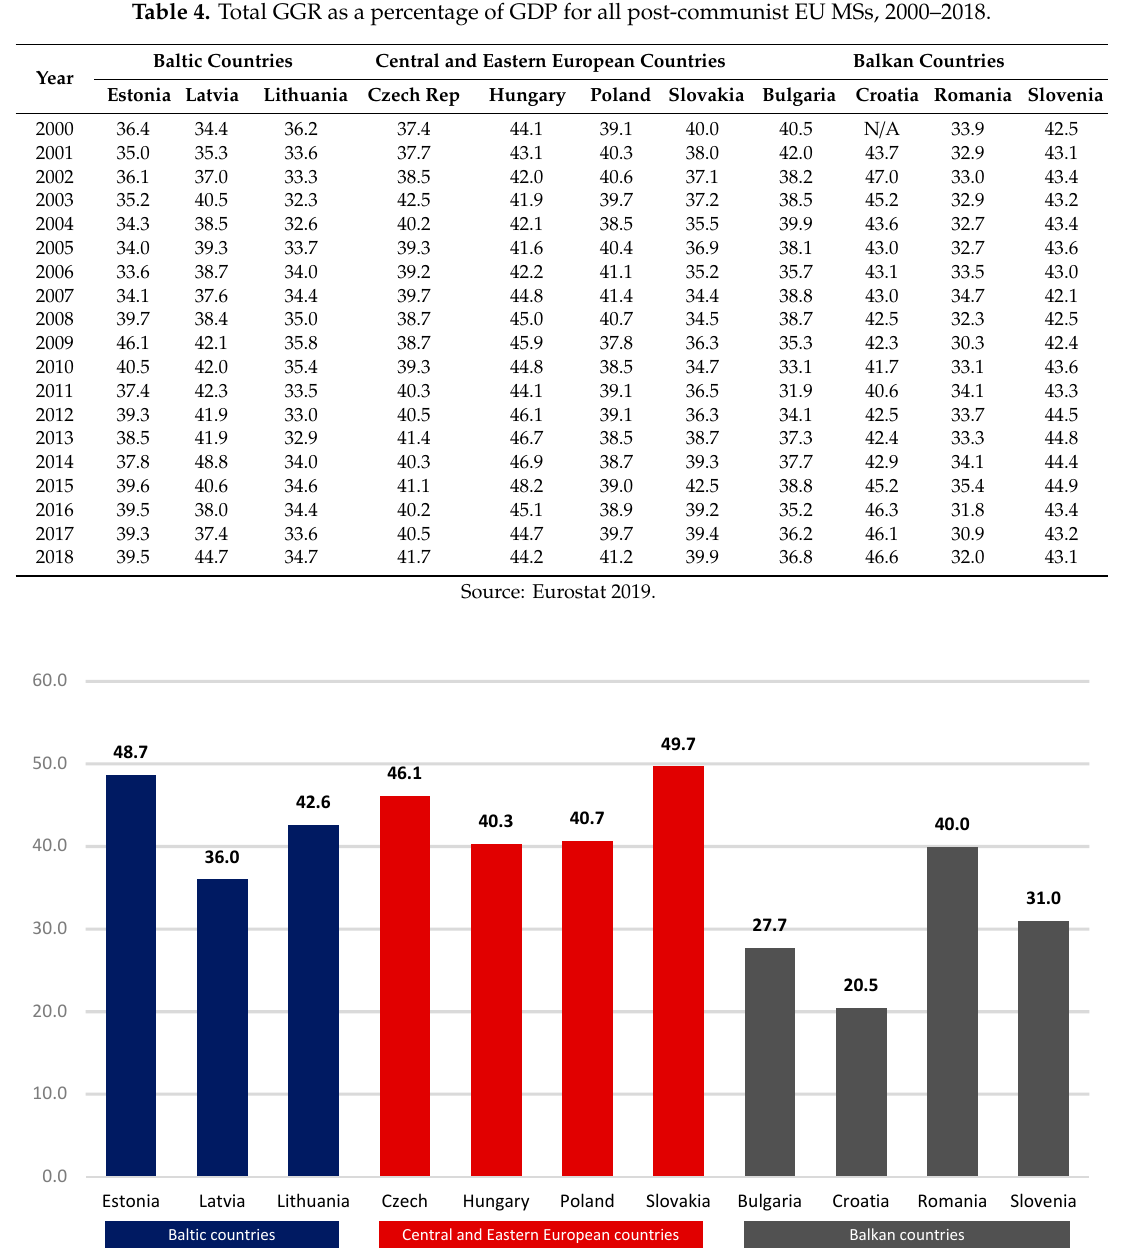
Figure 8. Total tax and contribution rate as a percentage of profit in post-communist EU MSs in 2018; Source: The World Bank.